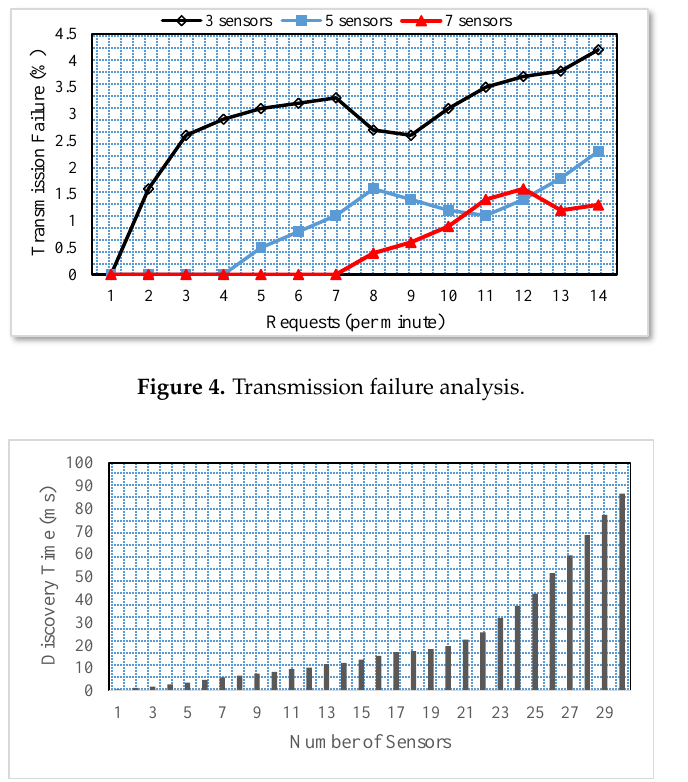
Figure 4. Transmission failure analysis.